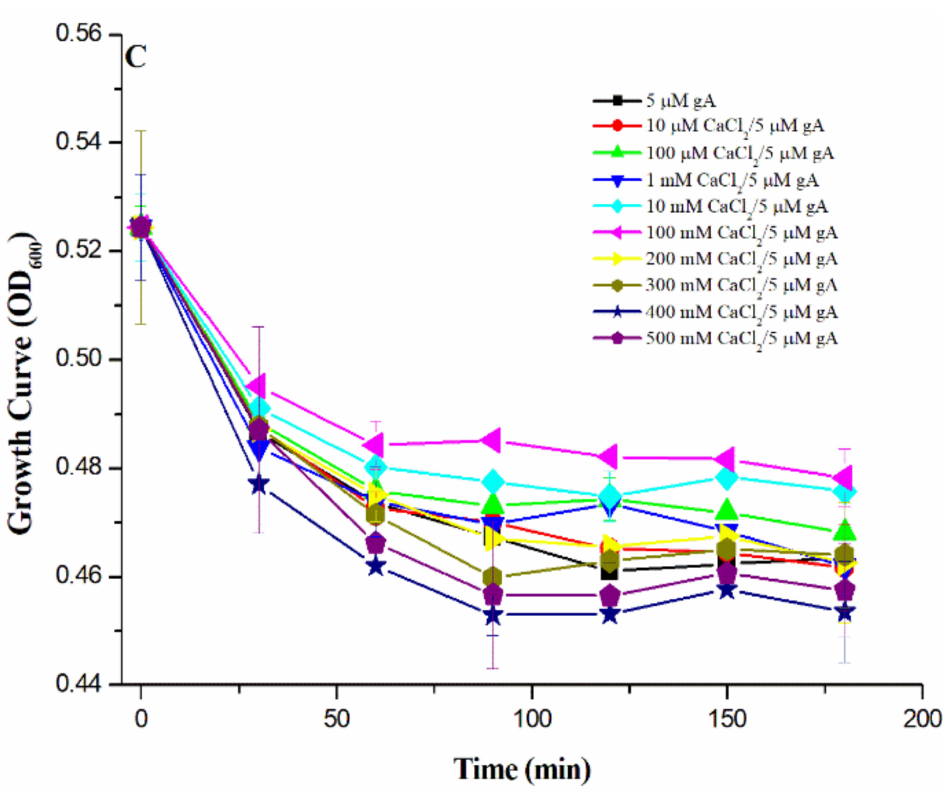
Figure 3. Effects of calcium ions on the growth rate of S. aureus in the presence of ( A ) 0–500 mM Ca 2+ concentrations only, ( B ) 0–500 mM of Ca 2+ ions and 1 µ M gA treatment, and ( C ) 0–500 mM Ca 2+ and 5 µ M gA treatment, respectively. ( n = 3, ** p ≤ 0.001, related to 1 µ M gA in ( B